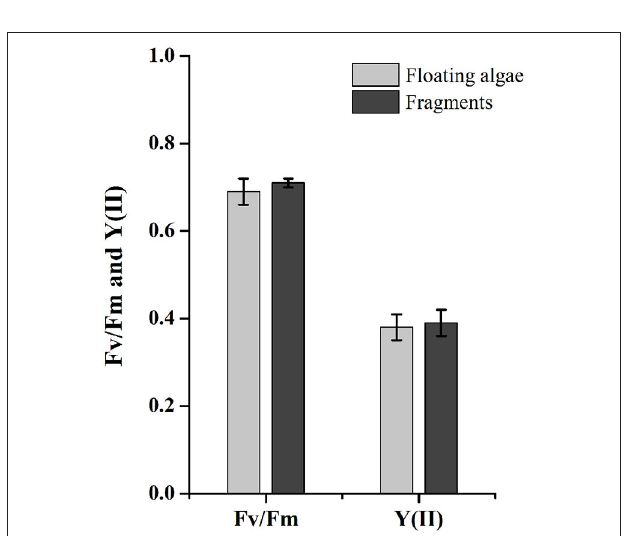
FIGURE 8 | Apohyale sp. in gastric contents of Stegophiura sladeni at Station Q (a,b) sampled in June of 2020.